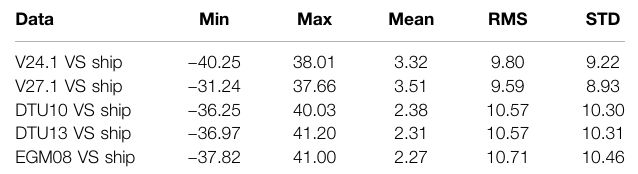
TABLE 5 | Comparison between marine gravity models and shipboard data in the coastal region of China, unit: mGal. Data